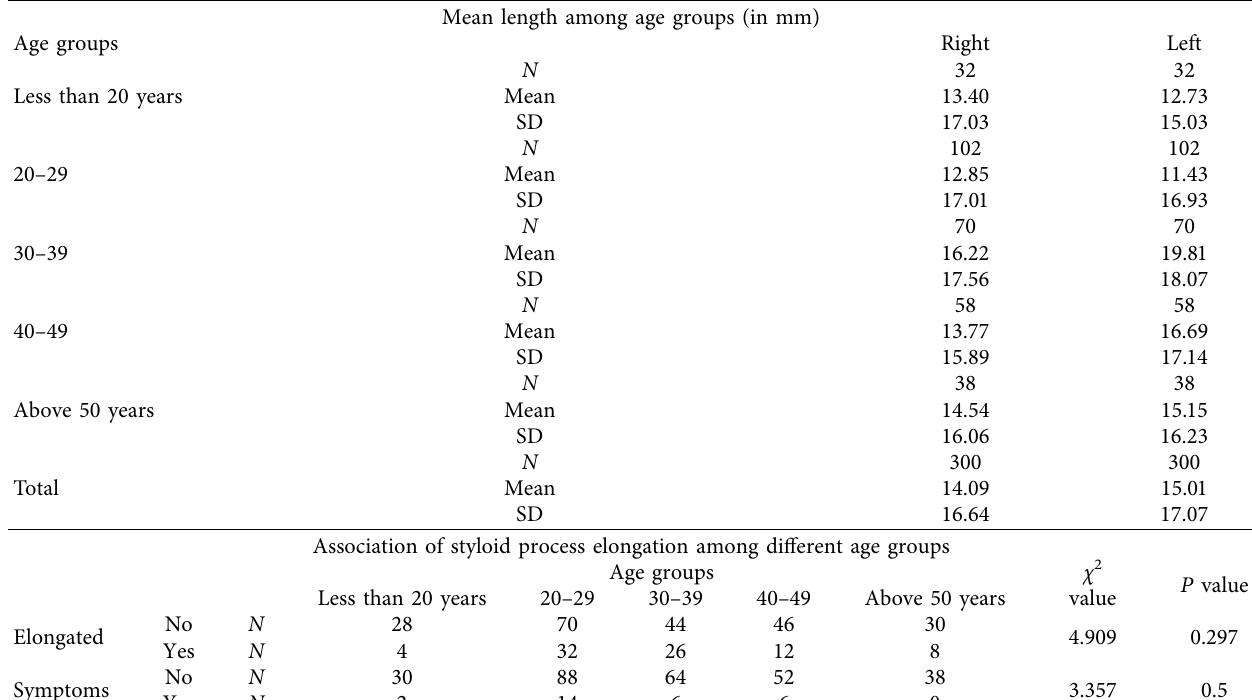
Table 2: Association of styloid process elongation, symptoms, and sides of the symptoms between different age groups. Mean length among age groups (in mm) Age groups Right